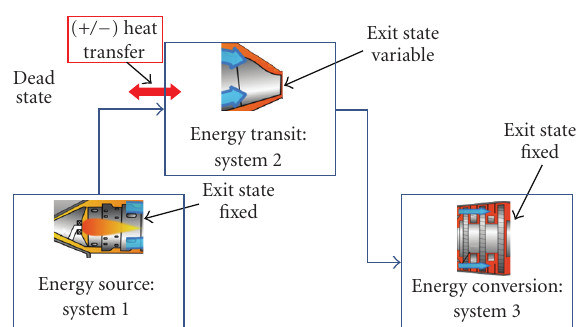
Figure 3: Sketch of simplified internal flow system illustrating possibility of heat transfer in System 2 (pipe). System 1 is assumed to operate at fixed conditions, while System 3 operates at fixed exit